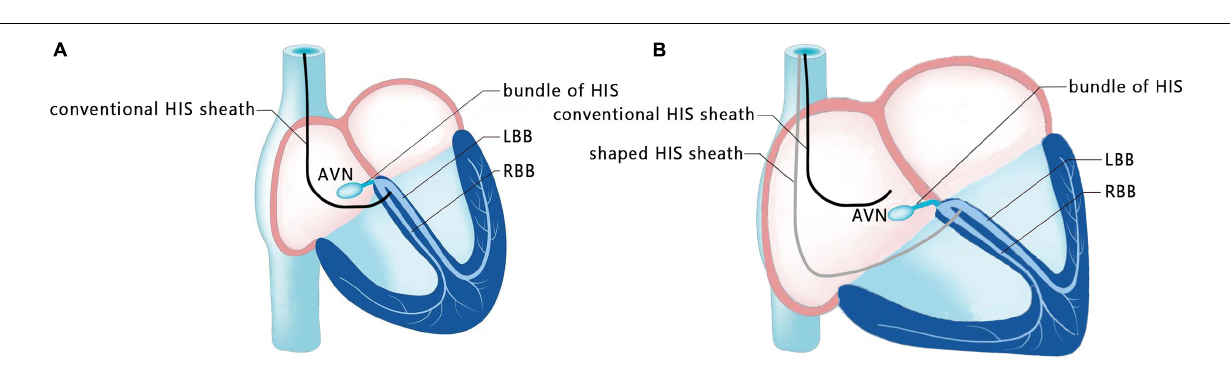
FIGURE 4 | Schematic diagram of shaping the sheath. (A) Conventional HIS sheath in patients with a normal size atrium. (B) Shaped HIS sheath in patients with an enlarged